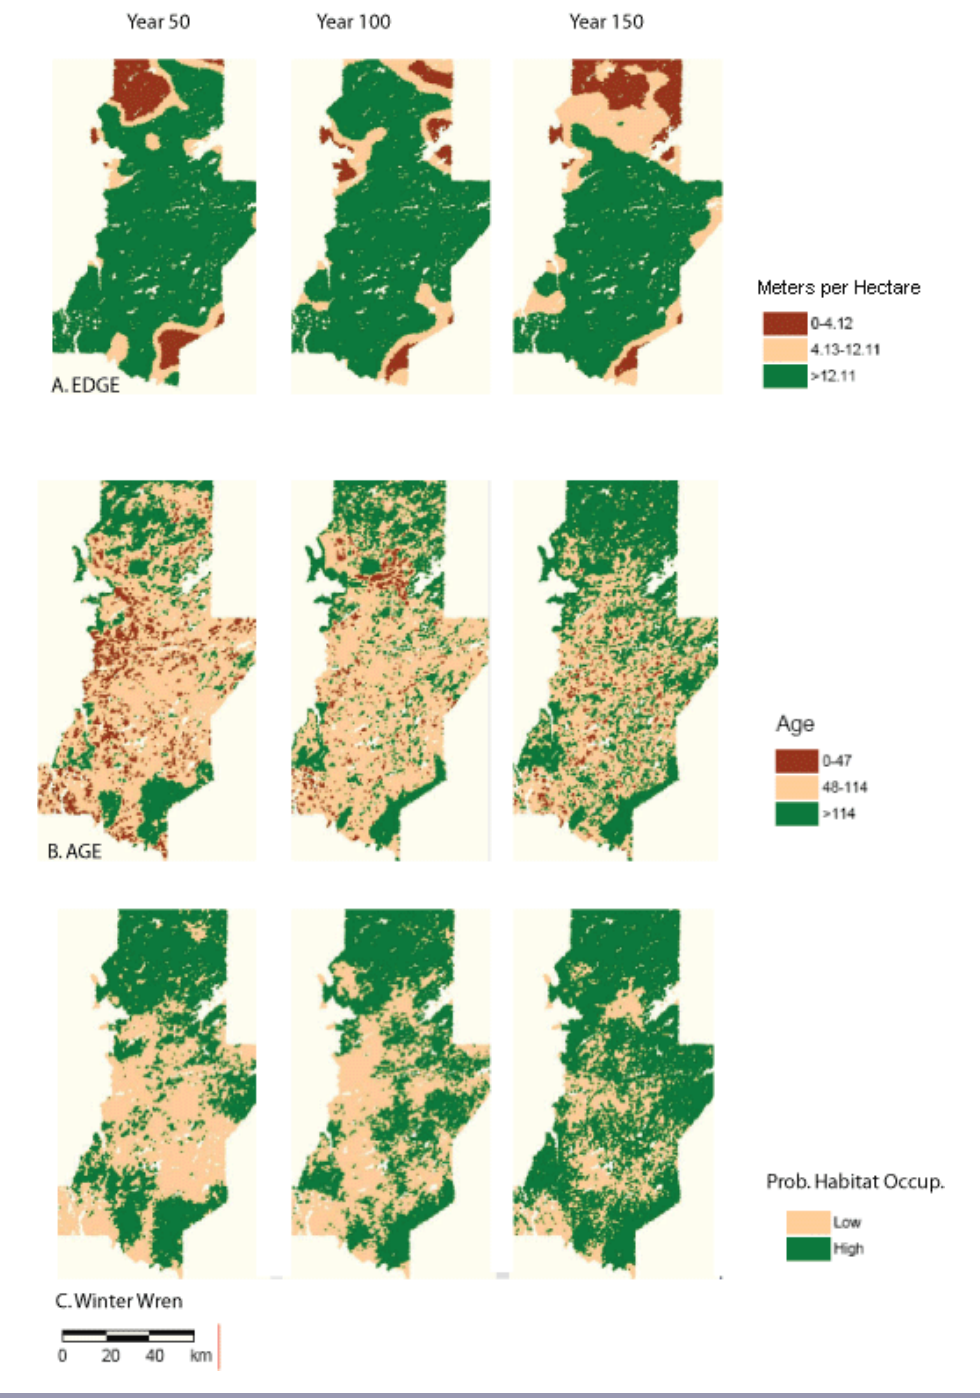
Fig. 12. Change in spatial patterns of landscape edge (EDGE), local age (AGE), and predicted habitat occupancy for Winter Wren, under ALLGUIDES scenario for years 50, 100, and